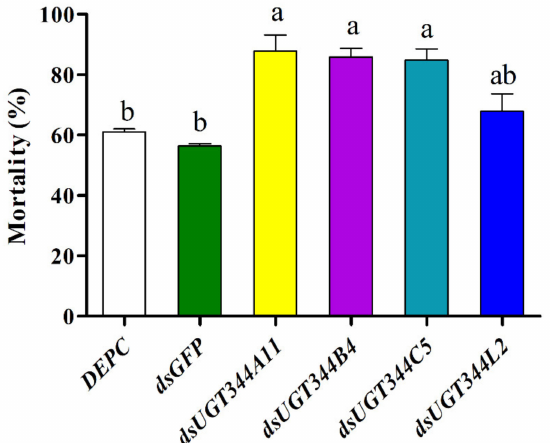
Figure 3. Effects of knockdown of UGT genes on the mortality of resistant aphids after treatment with the LC 50 of sulfoxaflor for 48 h. Different lowercase letters (a, b) with the bars indicated that the means are significantly different according to one-way ANOVA, followed by Tukey’s multiple comparison test ( p <